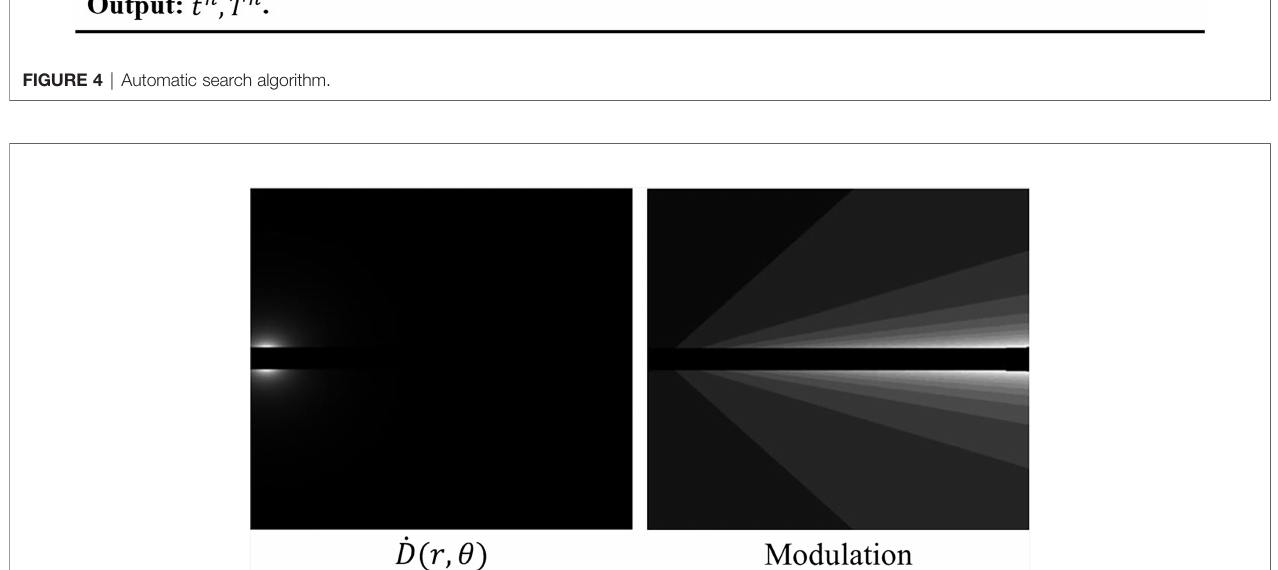
FIGURE 5 | Left: A dose rate map at a fi rst dwell position within our proposed method. Right: The modulation at a fi rst dwell position within our proposed method. The lighter shades of grey indicate less modulation due to the anisotropic nature of the